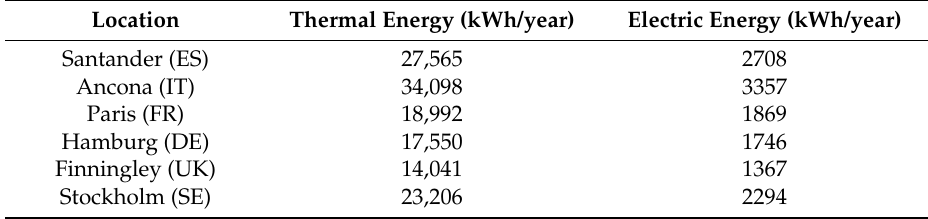
Table 5. Thermal and electric energy production of the Innova MicroSolar plant in different locations.